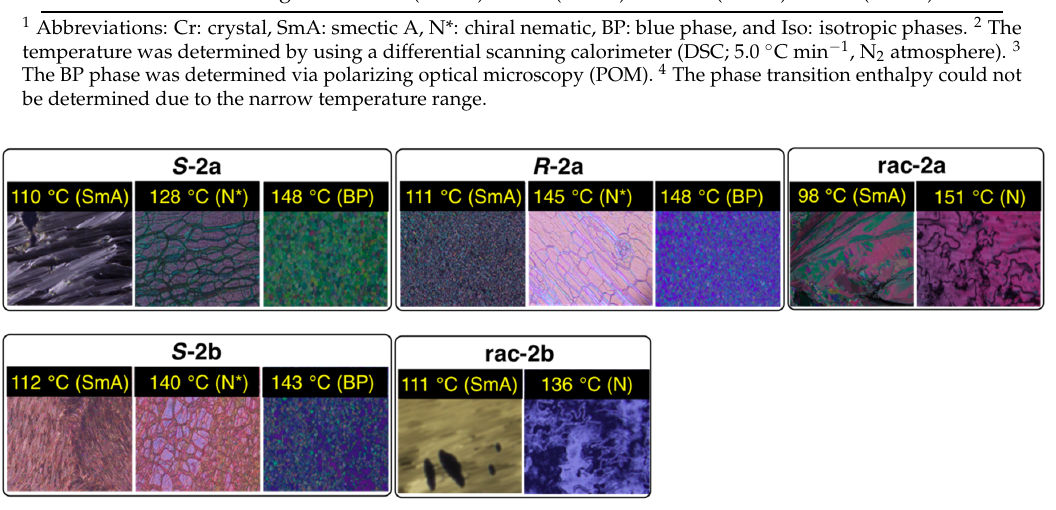
Figure 5. POM images of the LC phases observed in the second cooling process.